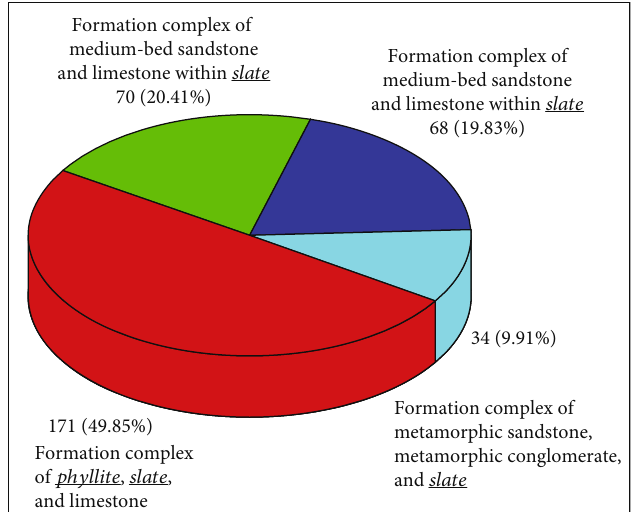
Figure 2: The mudslide on di ff erent